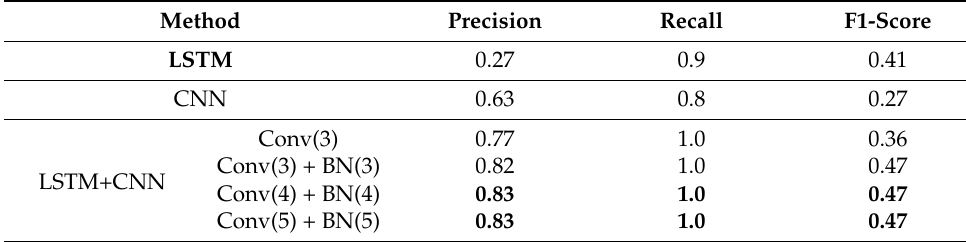
Table 1. Performance comparison of different model